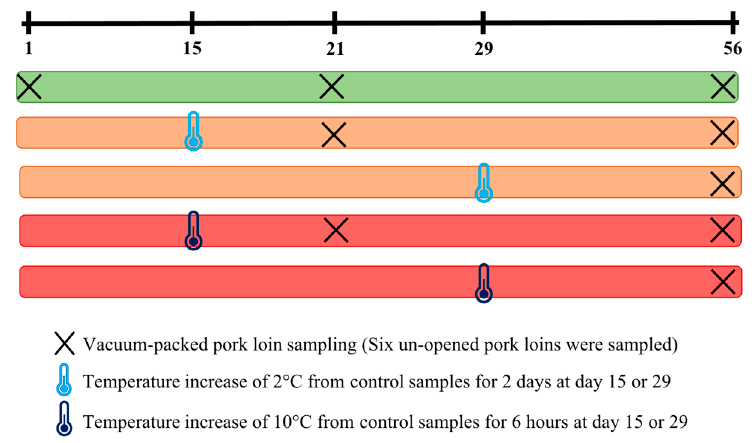
Figure 1. Sampling of six vacuum-packed pork loins for each condition per batch: control (stable temperature) sampled at day 1, day 21, and day 56; a temperature increase of 2 °C for 2 days at day 15, sampled at day 21 and day 56; a temperature increase of 2 °C for 2 days at day 29, sampled at day 56; a temperature increase of 10 °C for 6 h at day 15 sampled, at day 21 and day 56; a temperature increase of 10 °C for 6 h at day 29, sampled at day 56. This sampling was repeated for the 8 batches.